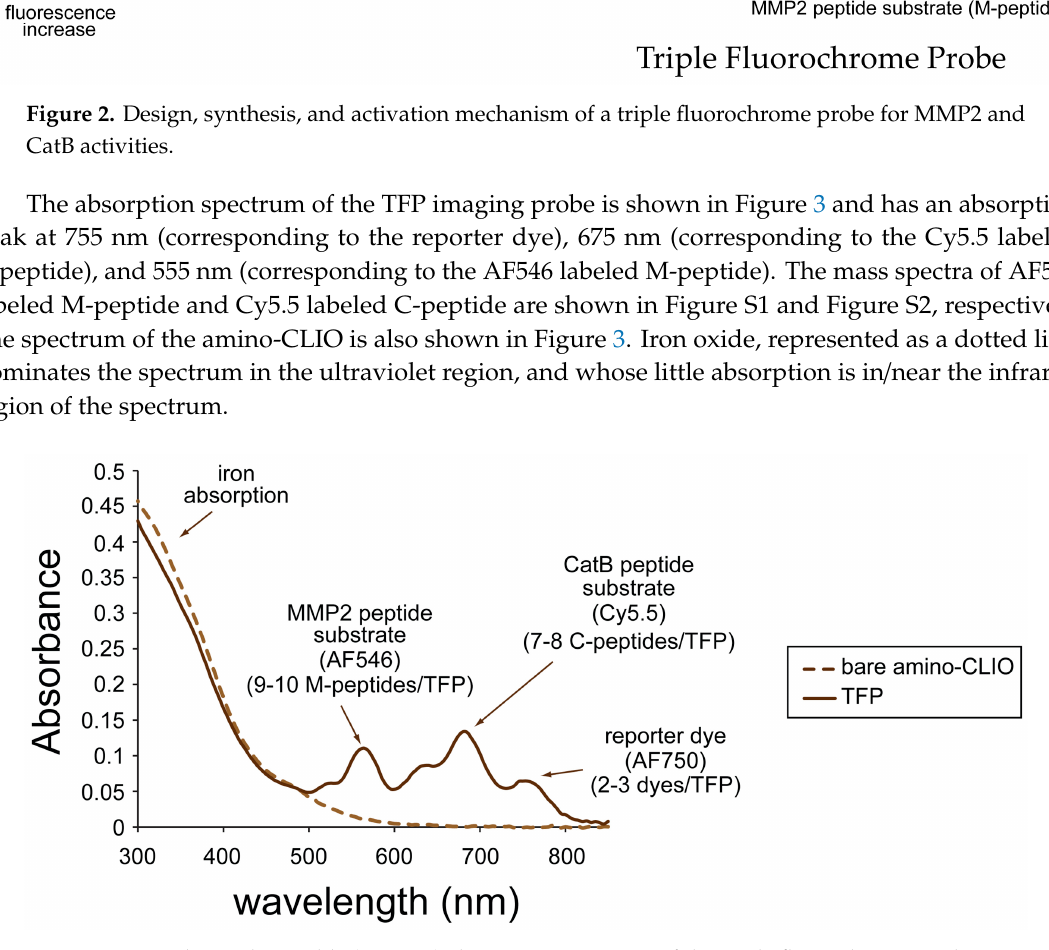
Figure 3. Ultraviolet-visible (UV-VIS) absorption spectrum of the triple fluorochrome probe.